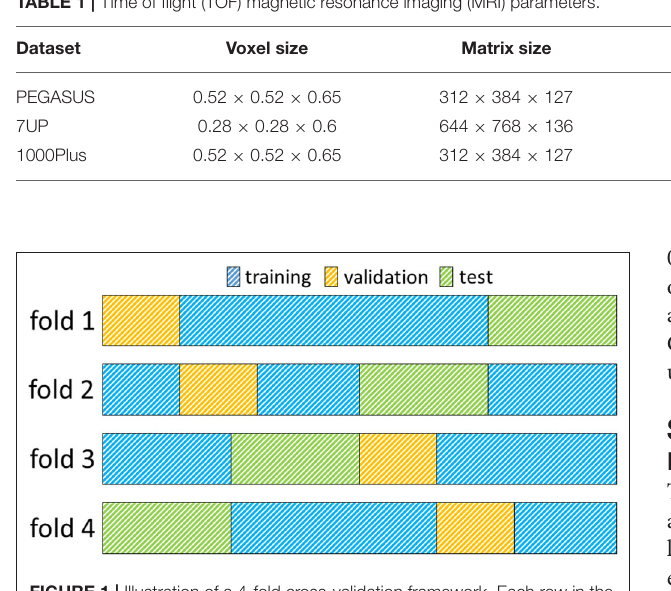
FIGURE 1 | Illustration of a 4-fold cross-validation framework. Each row in the figure represents a fold. Data assigned to the training- validation- and test sets are indicated with the colors blue, yellow, and green, respectively. In each fold, the training set comprises 60%, the validation set 15%, and the test set 25% of all images (170, 29, 65 images,